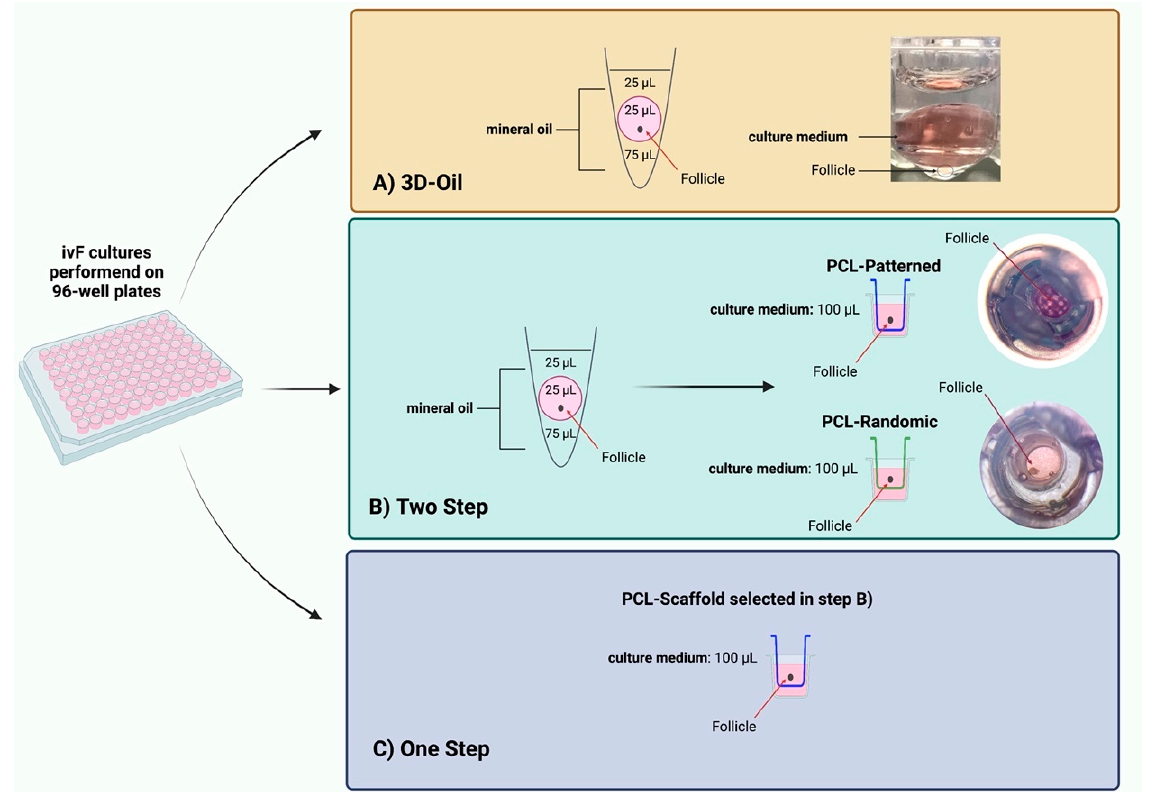
Figure 1. ivF culture protocols carried out on single follicle. Two-Step culture protocols with PCL- Randomic and PCL-Patterned fibrous scaffold were compared to the previously validated 3D-oil protocol. Secondly, Two-Step and One-Step PCL-Patterned approaches performances were